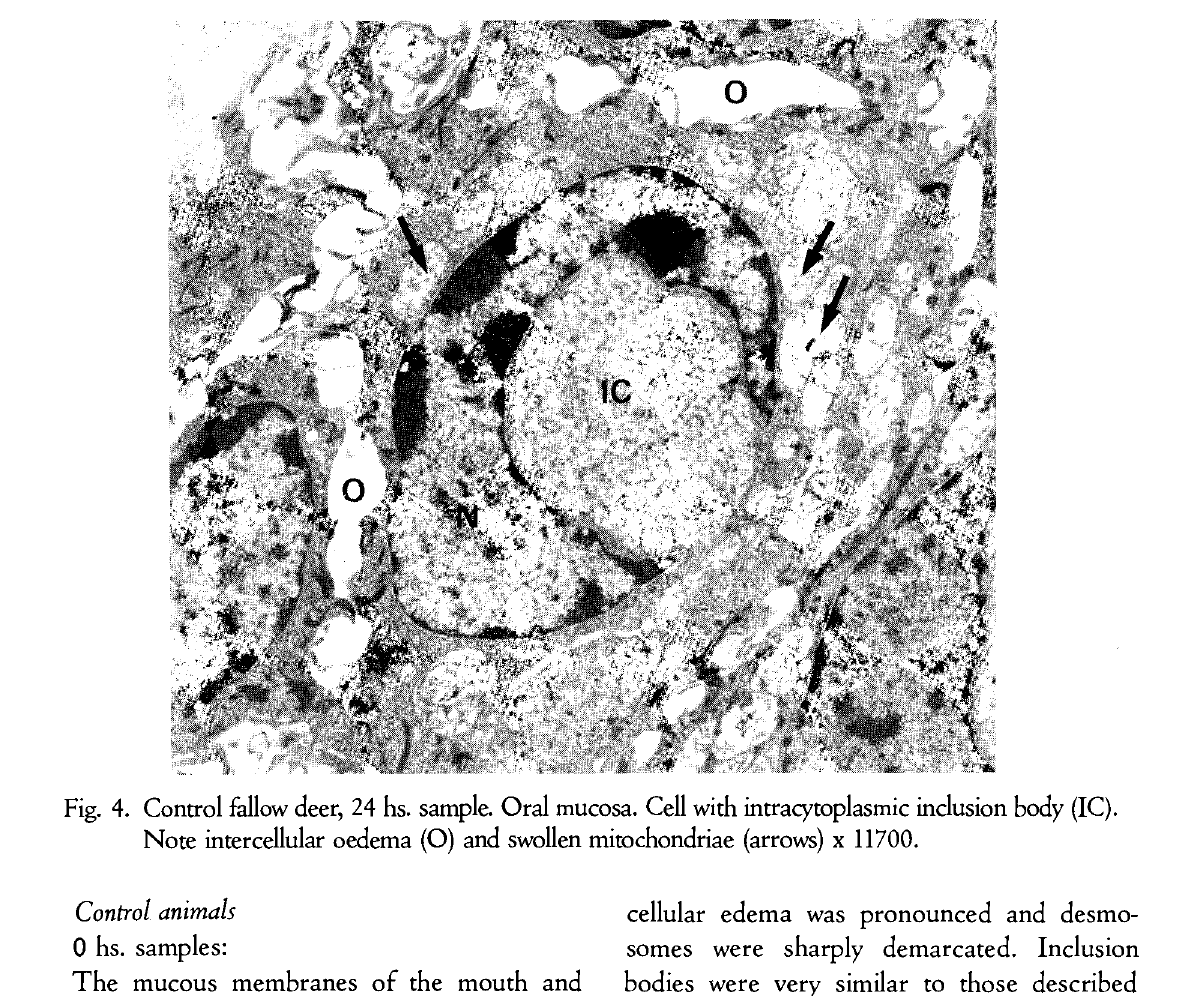
Fig. 4. Control fallow deer, 24 hs. sample. Oral mucosa. Cell with intracytoplasmic inclusion body (IC). Note intercellular oedema (O) and swollen mitochondriae (arrows) x